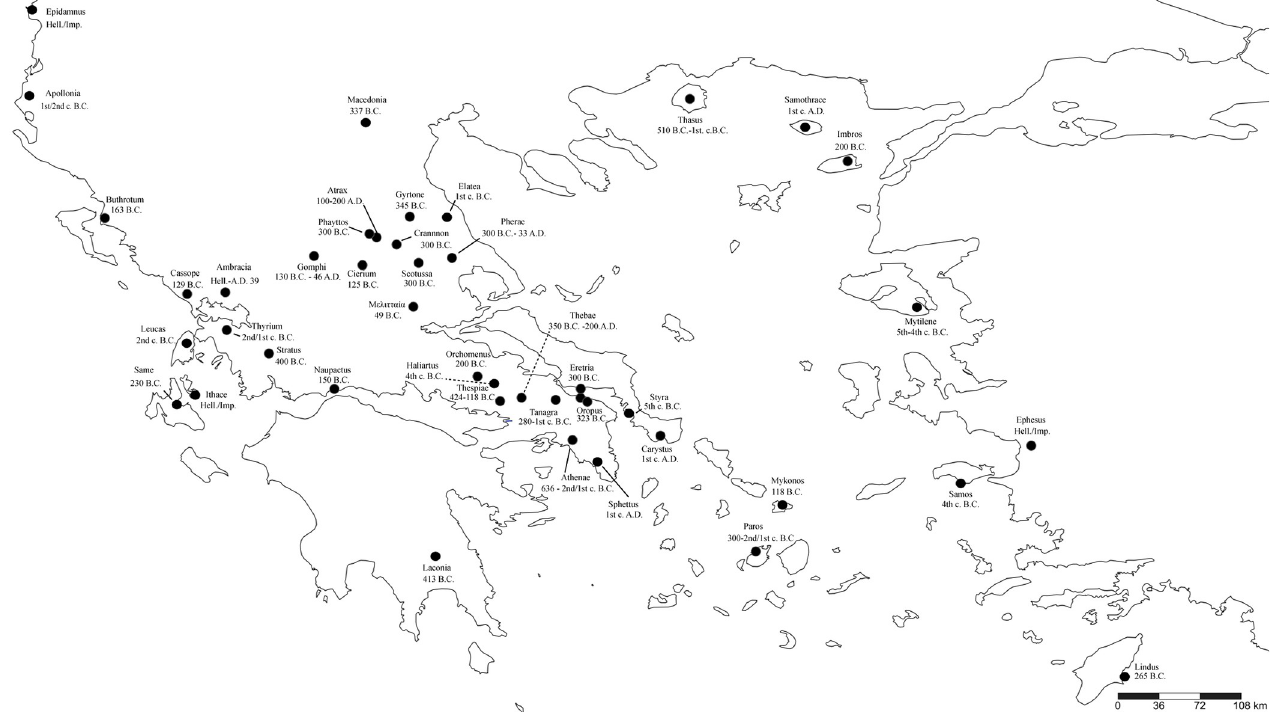
Fig 3. The distribution of personal names derived from φρῦν - and φροῦν in the Greek-speaking world between 600 BC and AD 200.